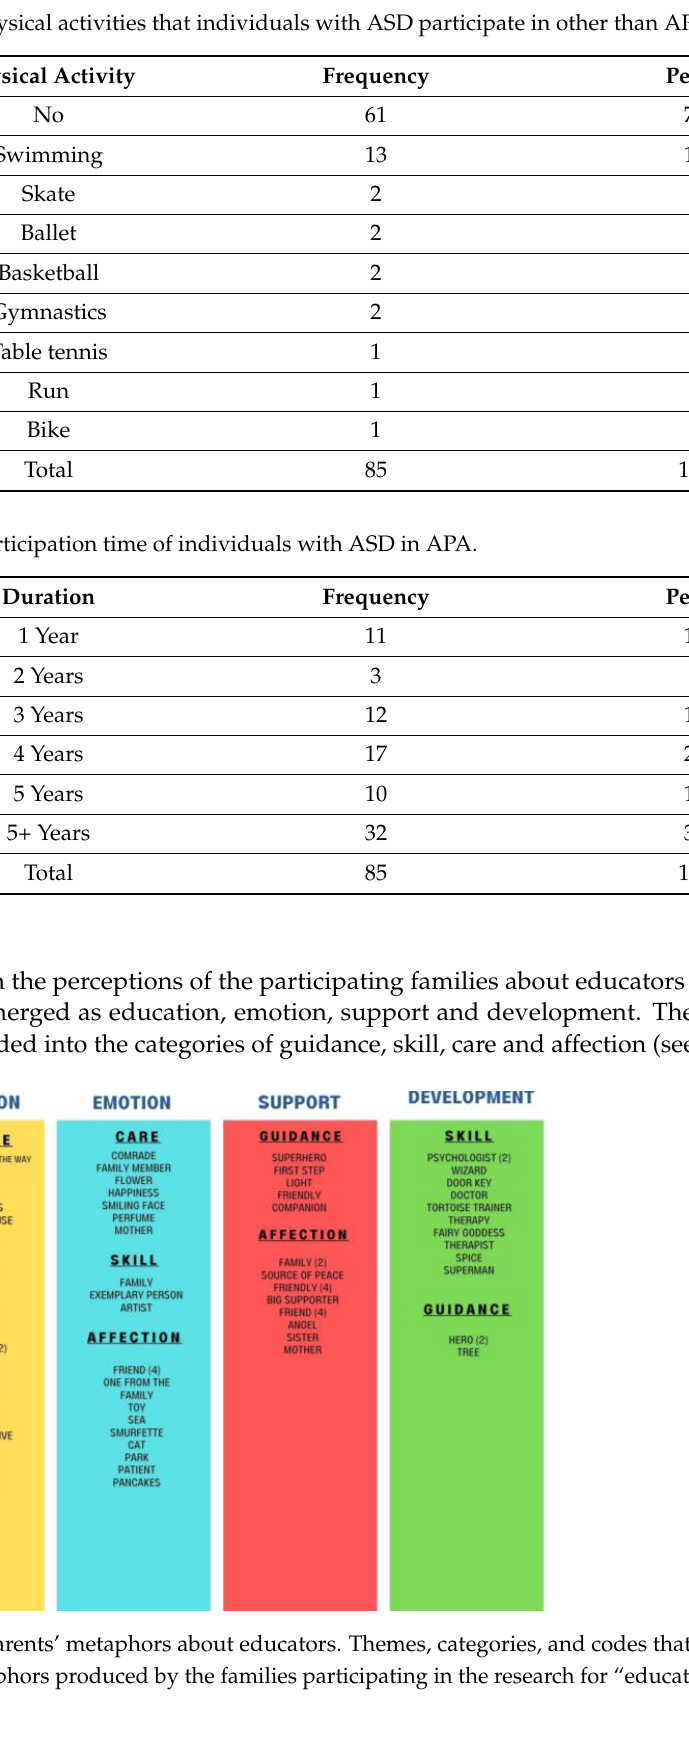
Table 7. Distribution of categories and codes for the metaphors that families produced about edu- cators ’ APA. Theme